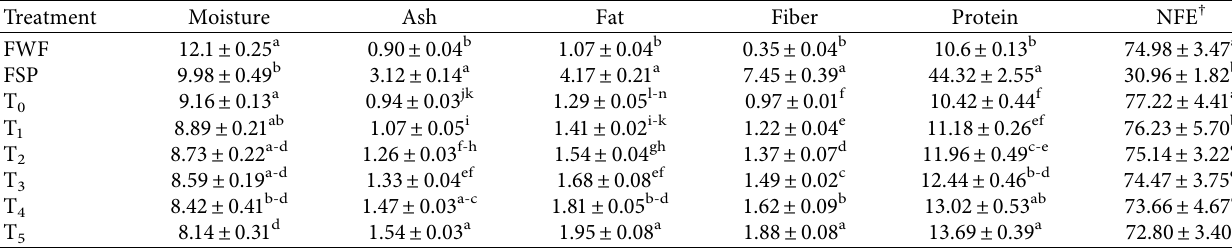
Table 3: Proximate composition of fine wheat flour (FWF), fenugreek seed powder (FSP), and supplemented composite noodles (g/100 g). Treatment Moisture Ash Fat Fiber